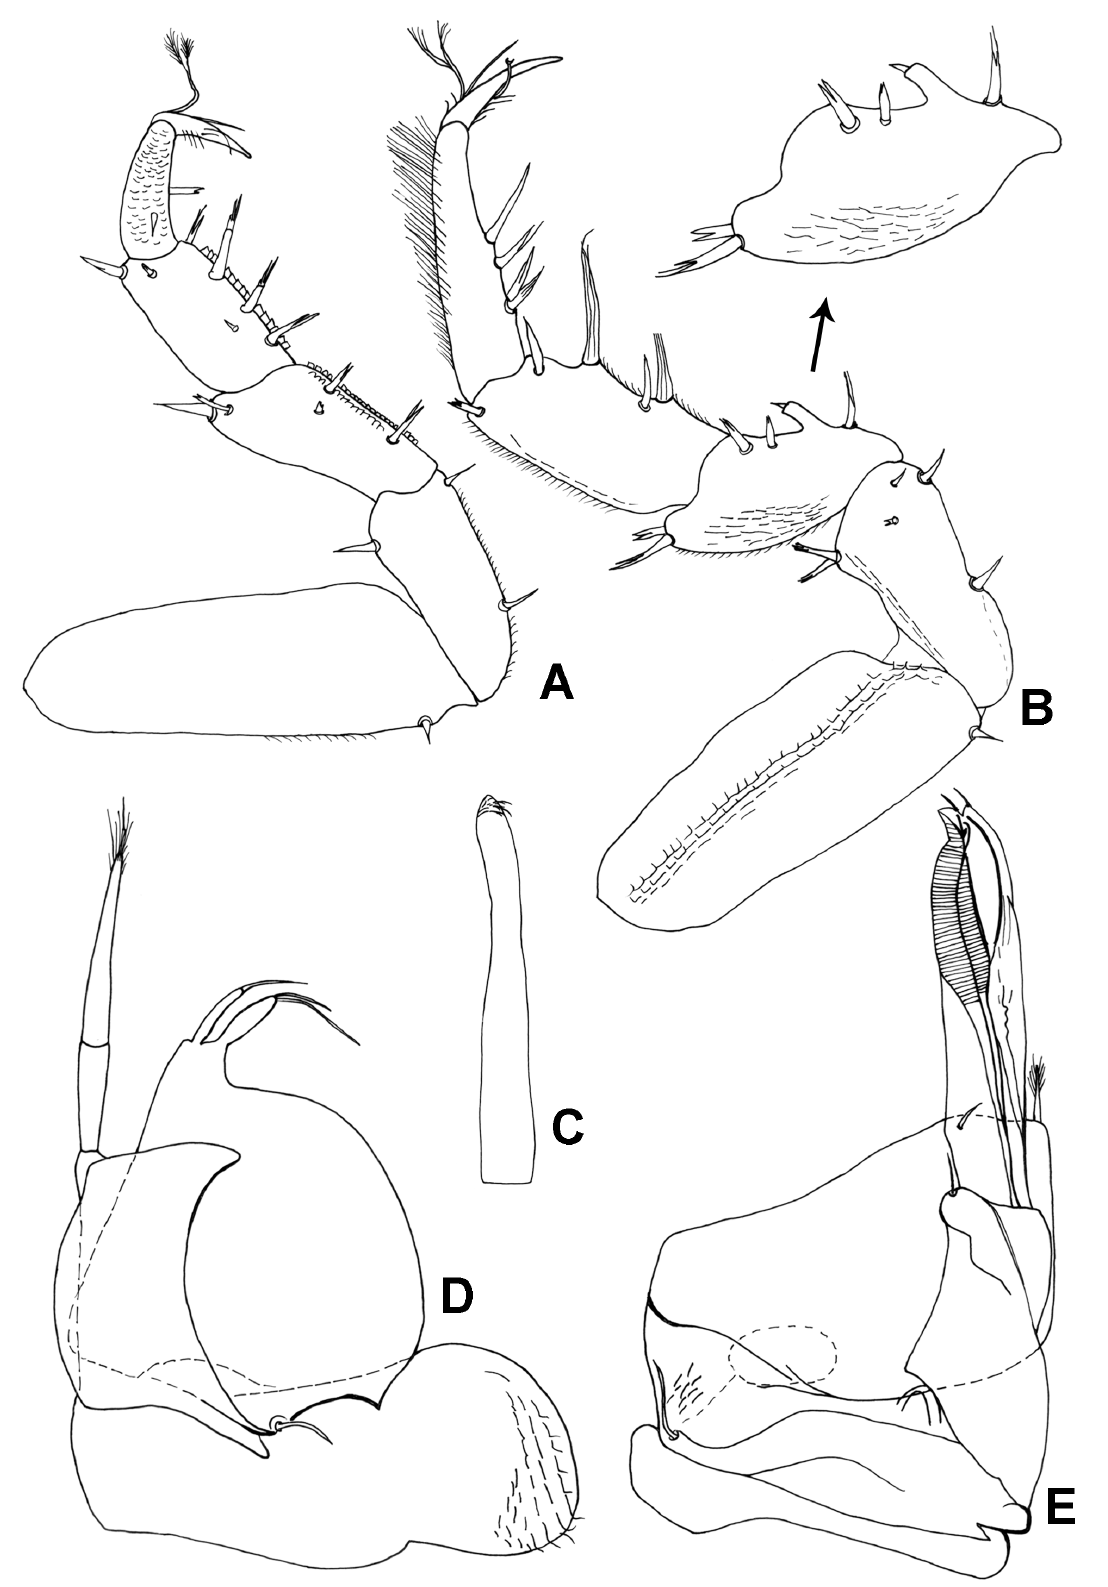
Fig. 9. Trichoniscoides sicoensis Reboleira & Taiti sp. nov. from Gruta da Cerâmica, Sicó, paratype, ♂. A . Pereopod 1. B . Pereopod 7. C . Genital papilla. D . Pleopod 1. E . Pleopod